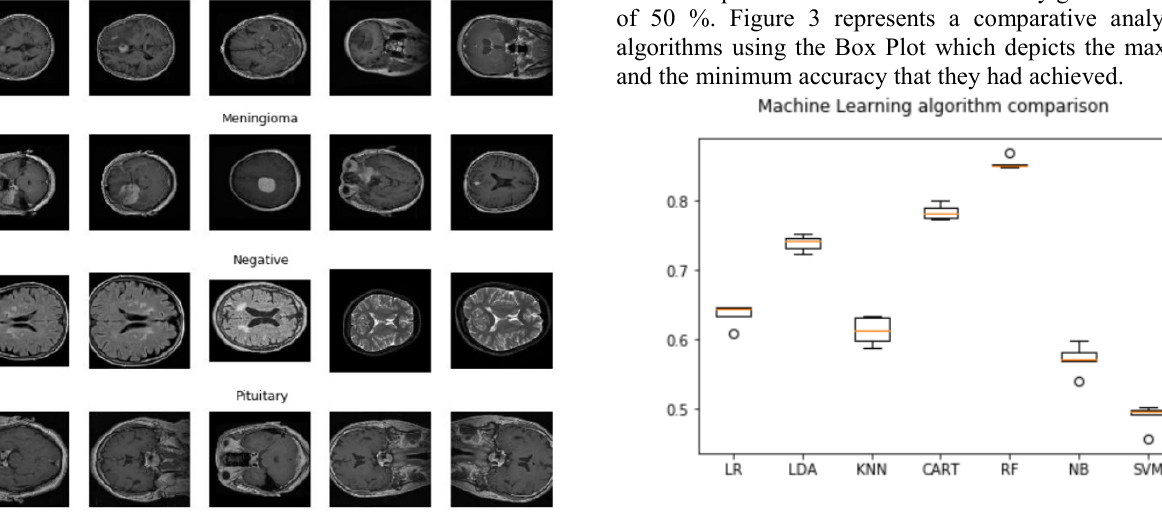
Figure 3. Comparative Analysis (using Boxplot) of Figure 2. Sample of T1 Contrast-Enhanced MRI (CE- different machine learning algorithms for classification. MRI) class images.